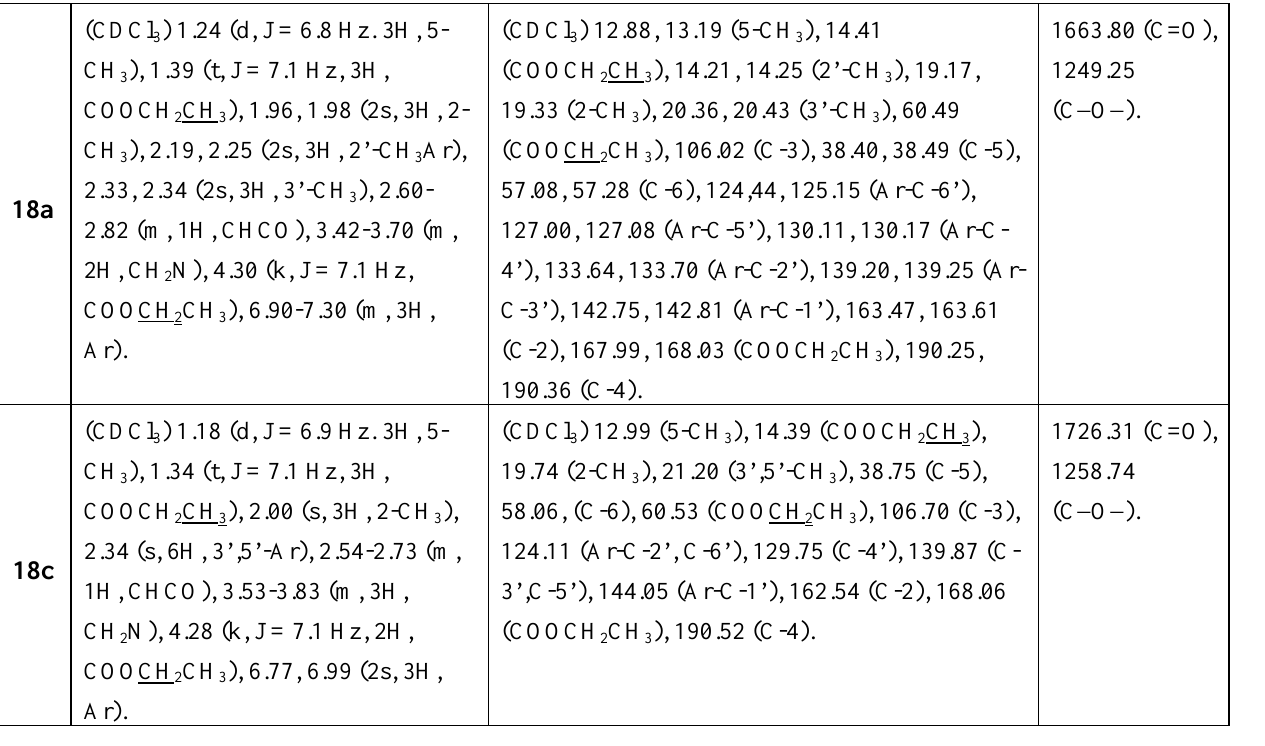
Table 2. The physical, analytical and yield data of the studied compounds Elemental analysis data (Calculated / Found)